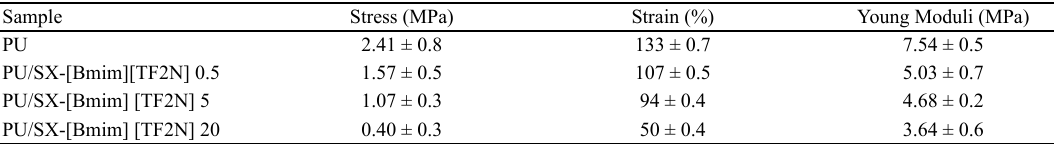
Table 3. PU and PU composites mechanical properties Sample